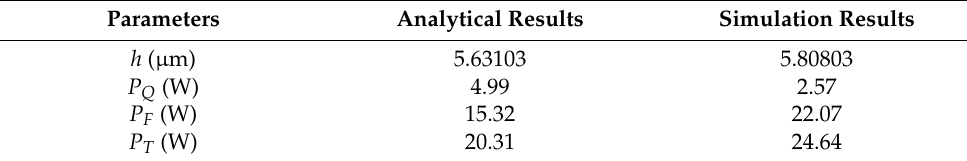
Table 3. Comparison between the analytical and simulation optimization